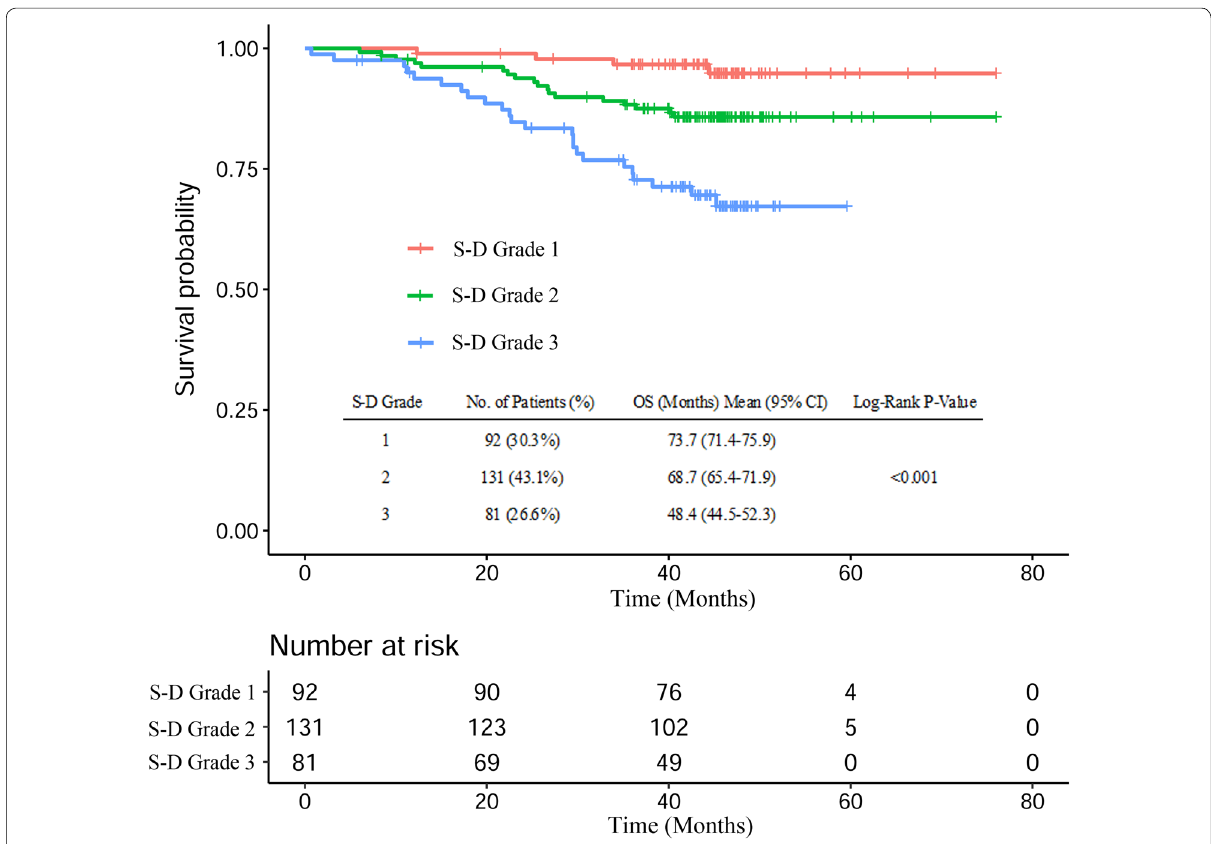
Fig. 2 Kaplan–Meier curves of S-D grade for OS in NPC patients